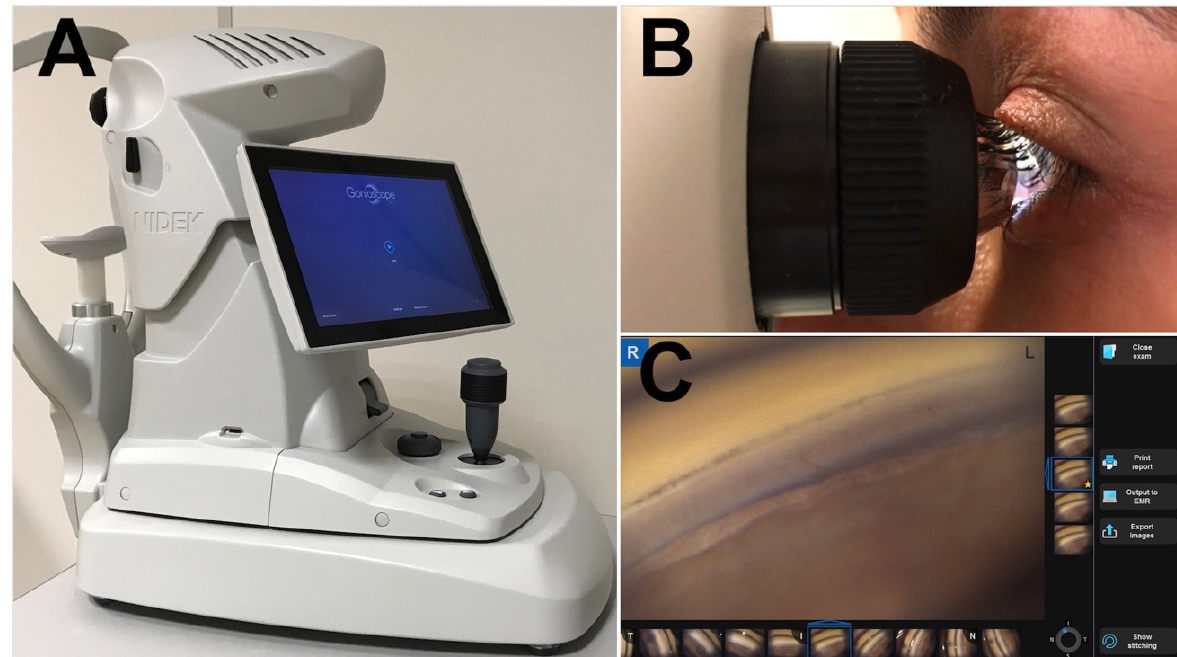
Figure 1. The GS-1 device. ( A ) GS-1 (Gonioscope GS-1; Nidek Technologies srl); ( B ) The examiner aligns the lens at the center of the cornea and then full 360° images of the angle are automatically acquired. Then lens is optically coupled with the cornea by a thin layer of gel; ( C ) The built-in software, controlled with multi-touch panel, permits acquisition and processing of the angle’s images.